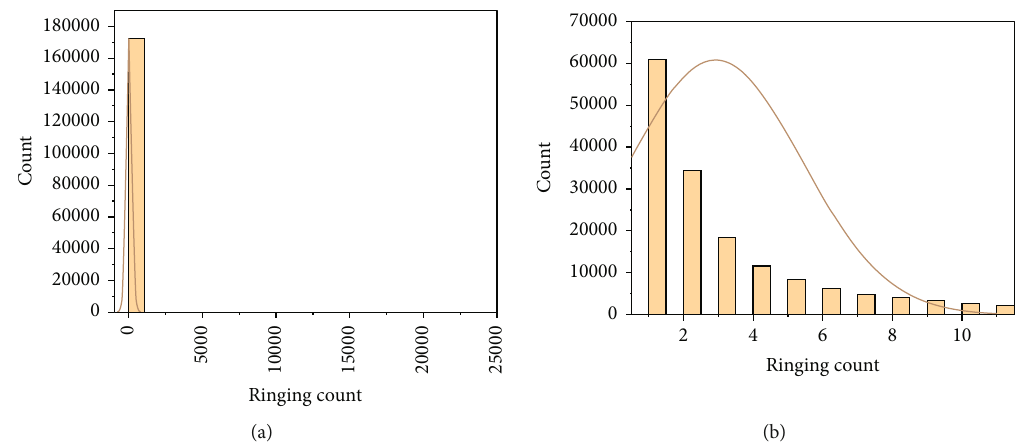
Figure 3: (a) Histogram of ring count distribution. (b) Histogram of ring count distribution after removing